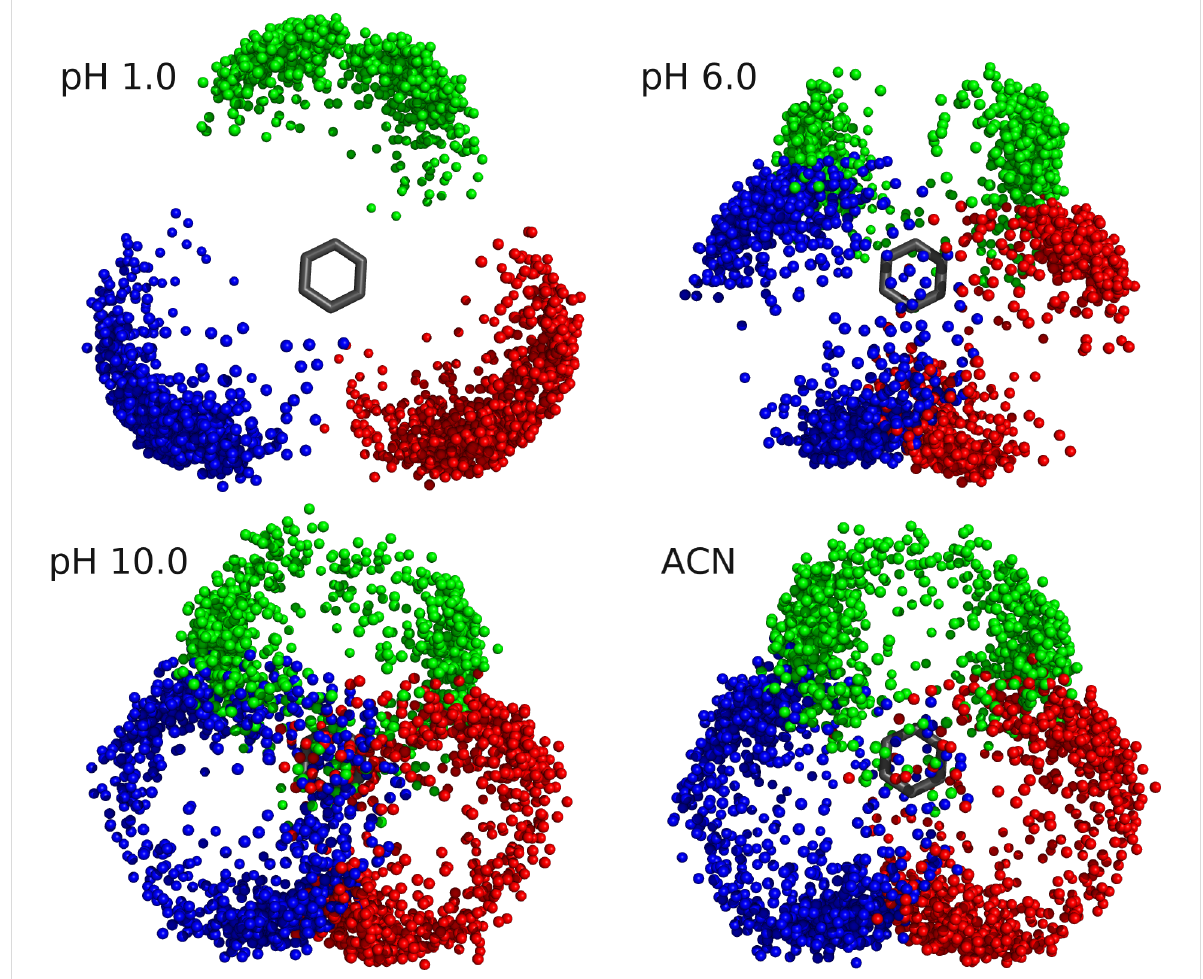
Figure 6: Schematic representation of the receptor arms positions. Pyrrolic nitrogen atoms positions relative to the phenyl ring in 900 conformations at pH 1.0, 6.0, 10.0 and in ACN.